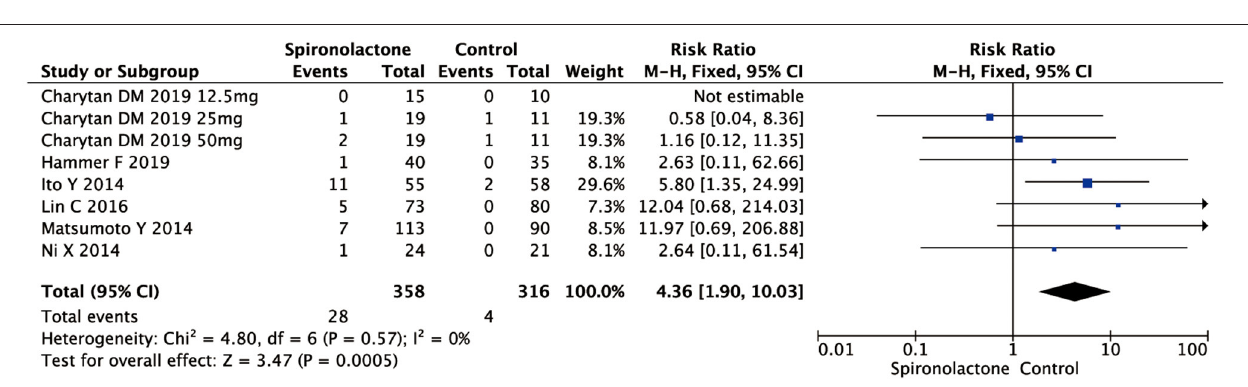
suggesting further researches to report outcomes according to